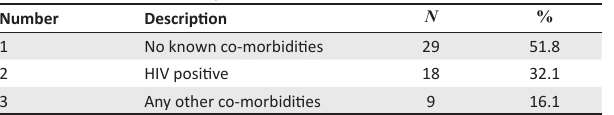
FIGURE 1: Travel history. TABLE 2: Past medical history.